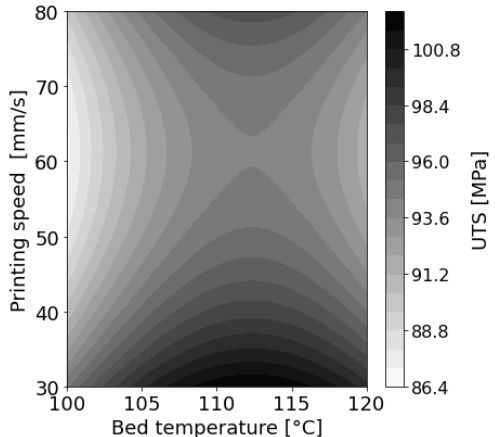
Figure A9. Contour plot for T ext and T bed according to the ML-based prediction model.